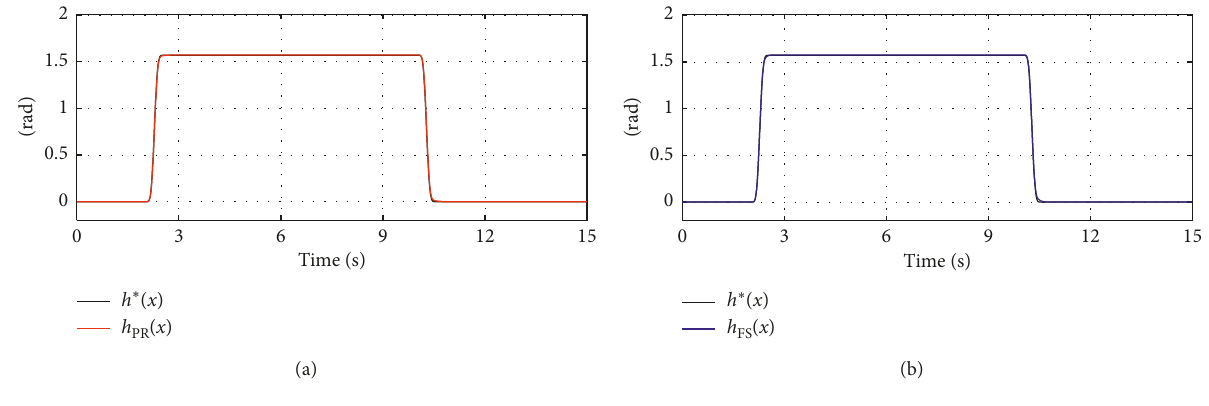
Figure 5: Trajectory tracking